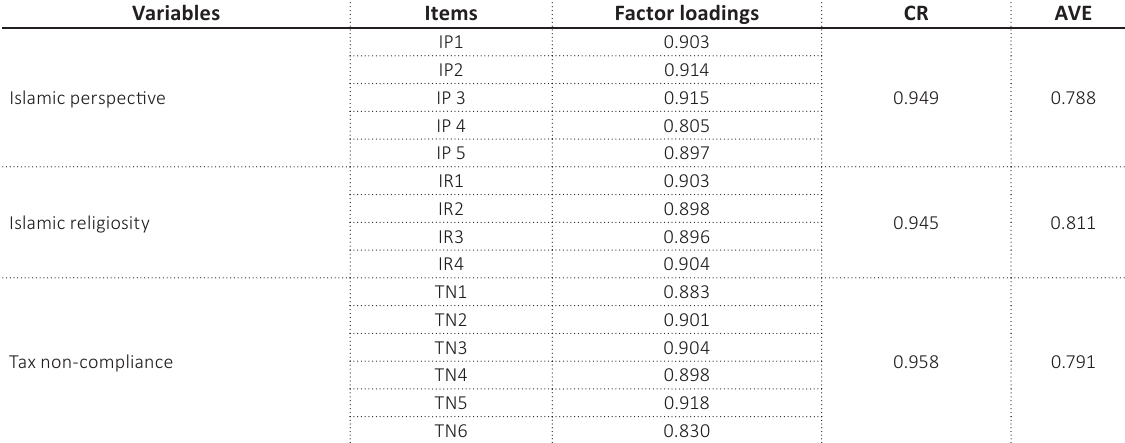
Table 2. Convergent validity